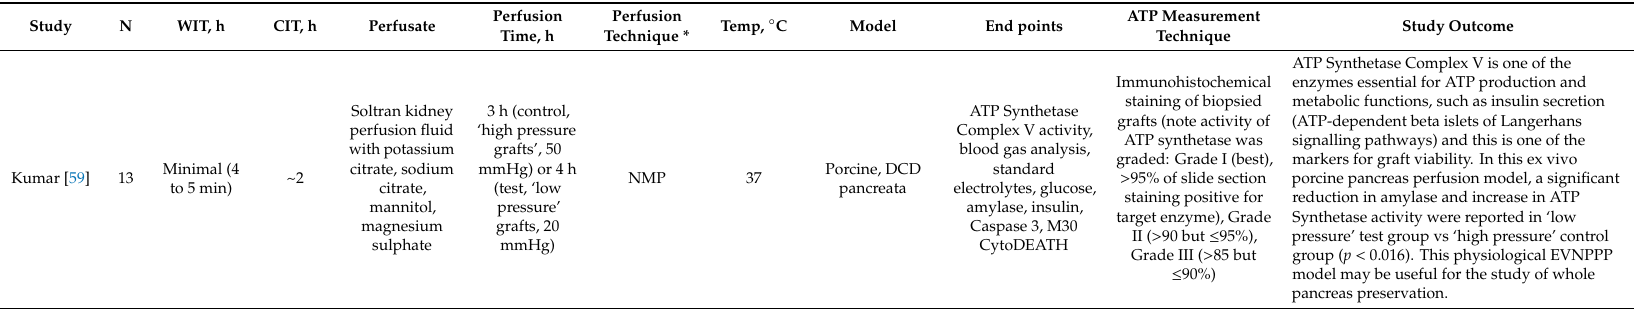
Table 9. Characteristics and outcomes of key animal study investigating NMP preservation of